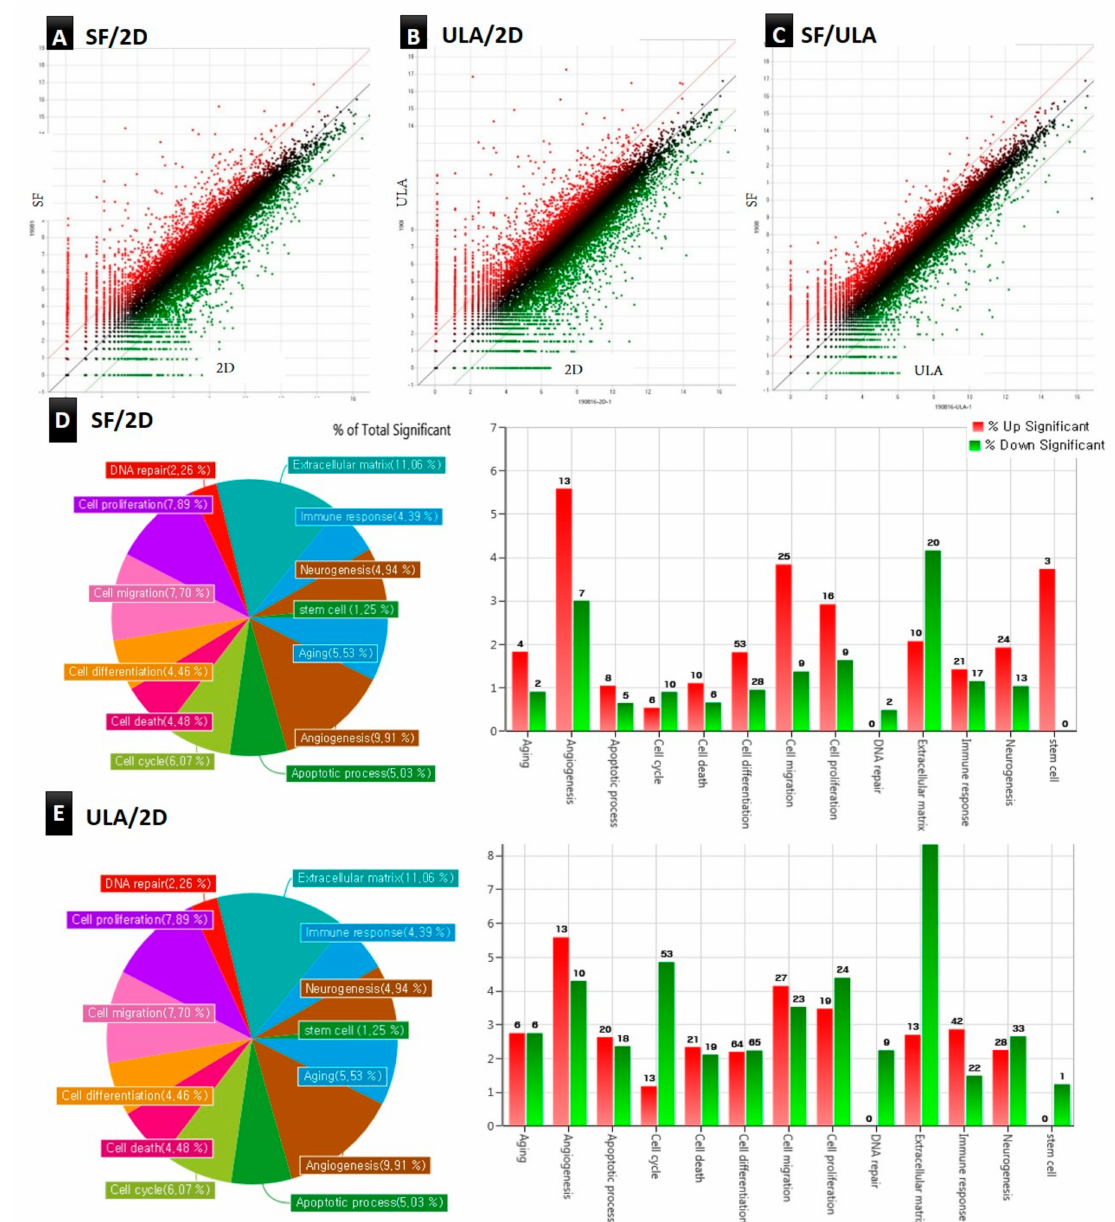
Figure 7. ( A – C ) Scatter plot of normalized data for two-fold threshold ( p < 0.05). The di ff erentially expressed genes (DEGs) are shown in green / red for down- / upregulation in control (2D), respectively. ( D , E ) Overview DEGs of DPSCs of SF and ULA groups compared to control (2D) group, respectively. The percentage of total significant DEGs are presented in the circular graphs. The gene category charts showed the DEG distributions of DPSCs with the following parameters: 10-fold changes, normalized data (log2) = 4, p <